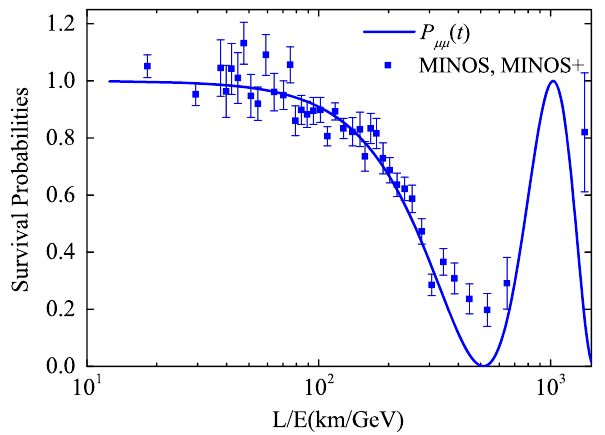
Fig. 1 The Long-range survival probabilities ν μ → ν μ (solid line, blue) as a function of the distance traveled per energy L / E with the initial muon flavor state. The solid line is theoretical value and the data of MINOS and MINOS+ Collaborations (blue square) are addressed from Refs.